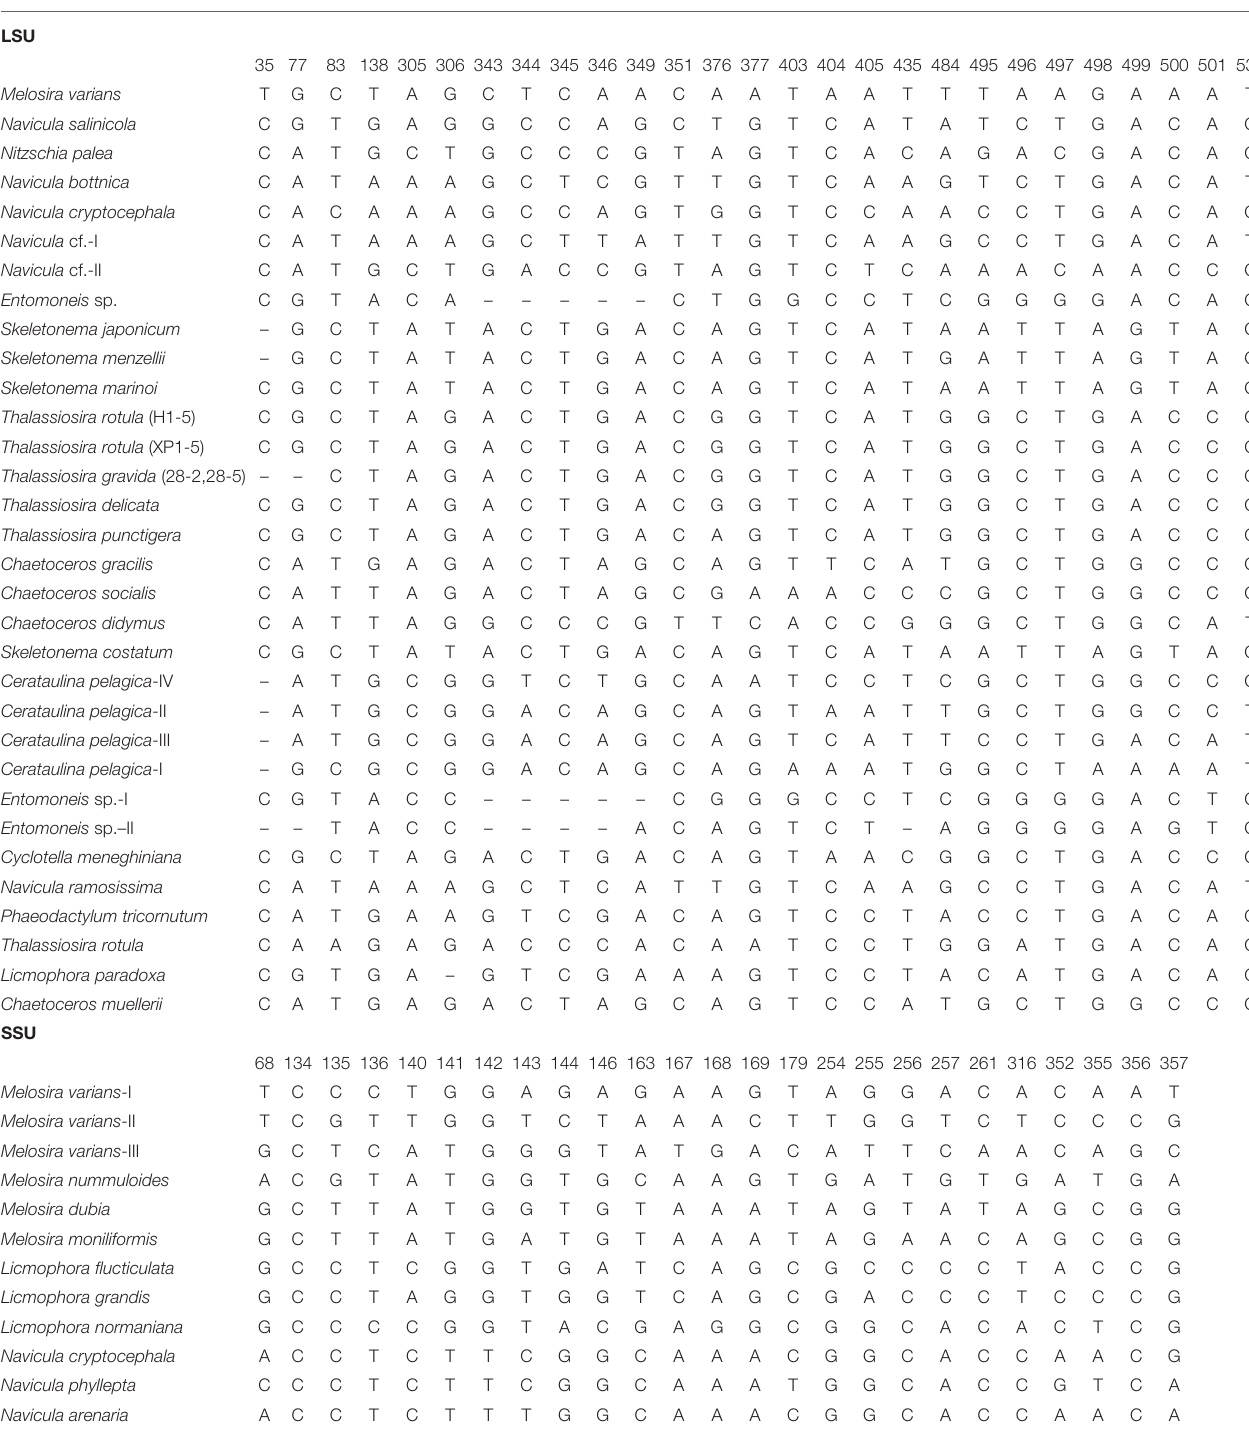
TABLE 3 | Combinations of diagnostic nucleotides for species assignments in Figure 3 (LSU and SSU) by CAOS analysis. Species Positions LSU Melosira varians